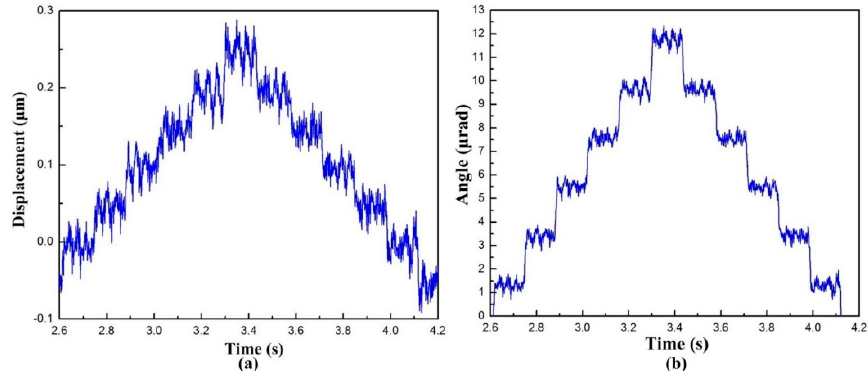
Figure 13. Experimental resolutions of ( a ) the output end of the lever and ( b ) the output center triangular stage of the VPD.